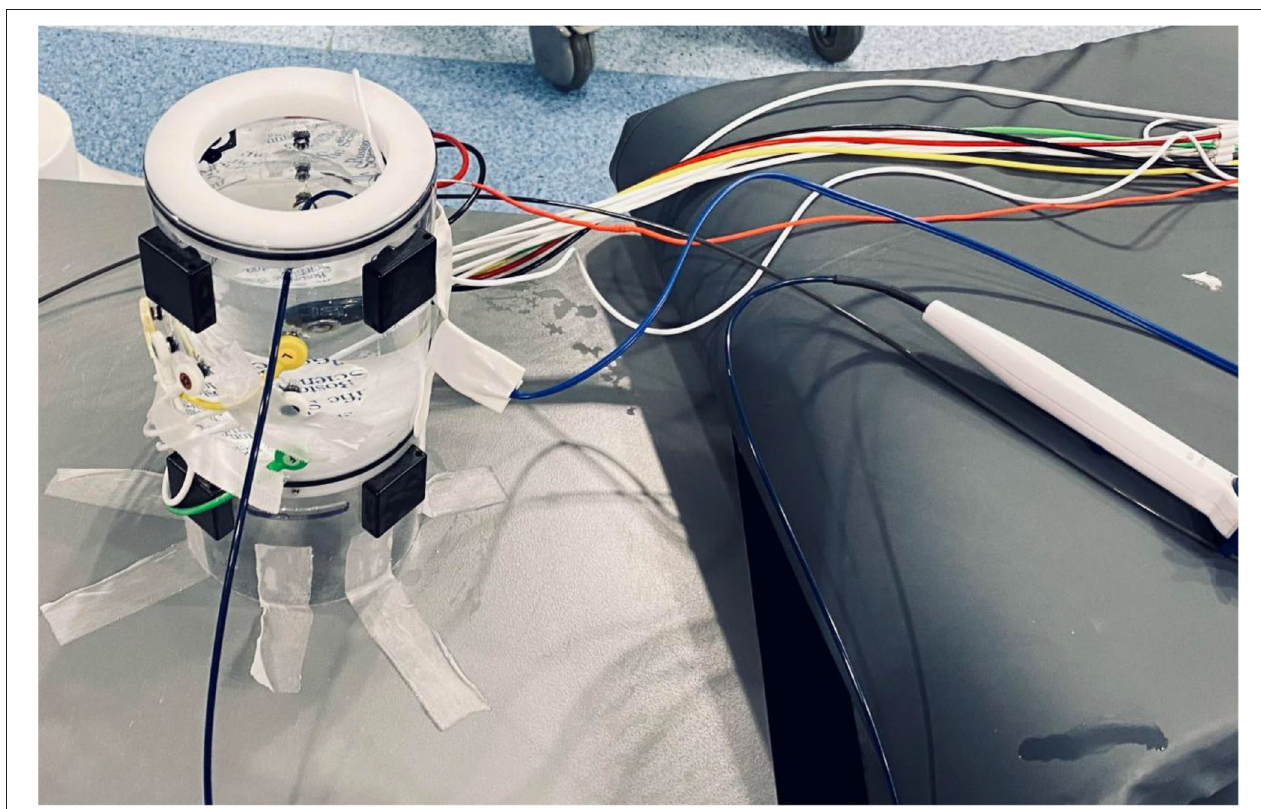
FIGURE 2 | Accuracy testing setup “ in vitro ”. Dedicated testing phantom with all EAM cables connected, IntellaMap Orion catheter, and DiamondTemp ablation catheter submerged in the saline within the phantom.